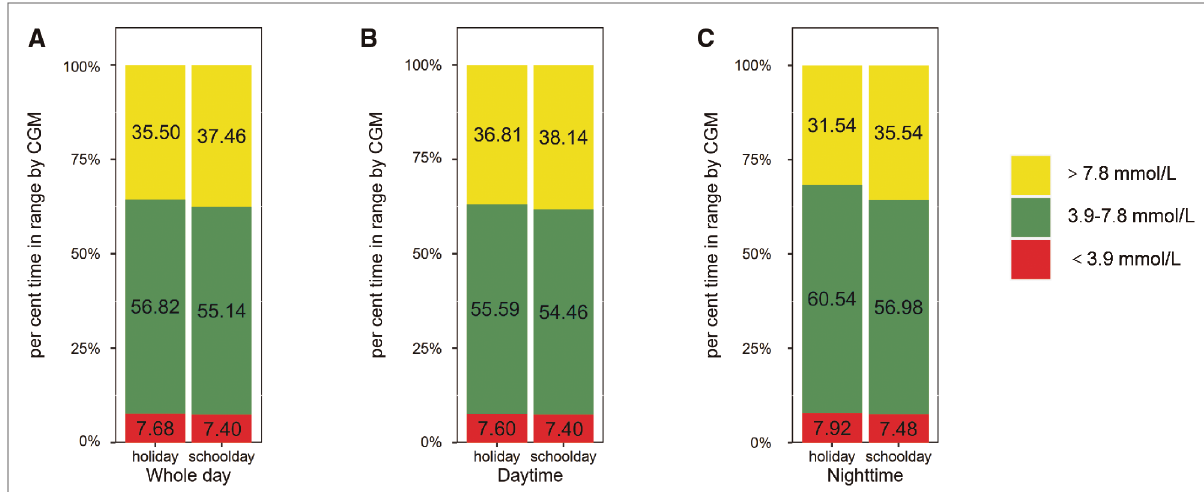
FIGURE 1 Comparison of glycemic metrics in children group: holidays vs. schooldays ( A ) Comparison of 24-hour CGM metrics between holidays and schooldays; ( B ) Comparison of daytime CGM metrics between holidays and schooldays; ( C ) Comparison of nighttime CGM metrics between holidays and schooldays; CGM, Continuous glucose monitoring; TIR 3.9 – 7.8, The time spent in target glucose range between 3.9 – 7.8 mmol/L; TAR 7.8, the proportion of time spent with glucose levels above 7.8 mmol/L; TBR 3.9, The proportion of time spent with glucose levels below 3.9 mmol/L.